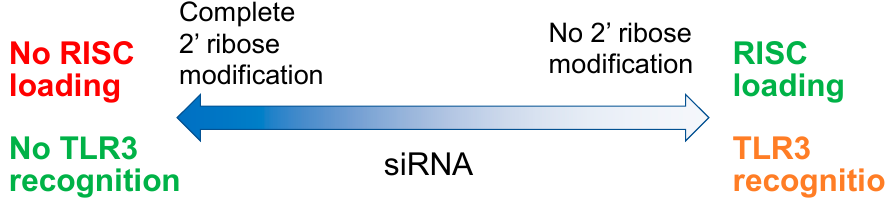
Figure 3. The balance between siRNA modification RISC loading and TLR3 recognition.